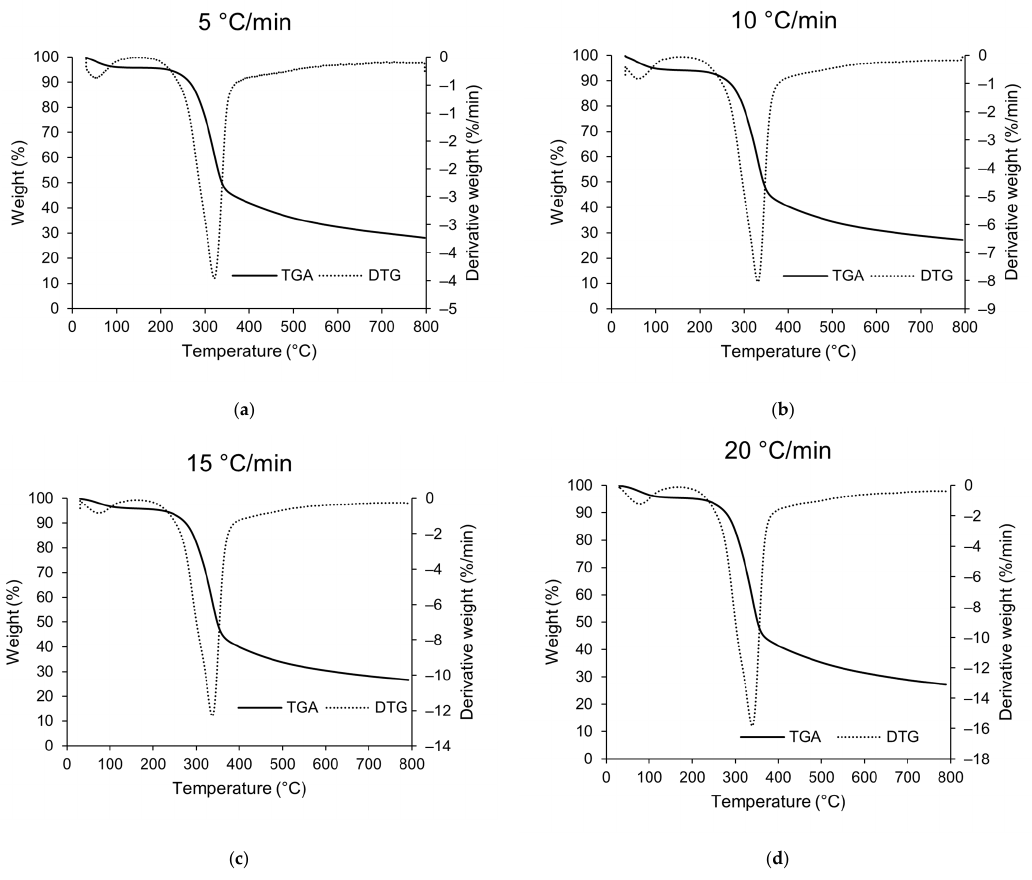
Figure 5. Wild sugarcane biomass thermogravimetric analysis and derivative thermogravimetric at heating rates of: ( a ) 5 °C/min; ( b ) 10 °C/min; ( c ) 15 °C/min; ( d ) 20 °C/min.